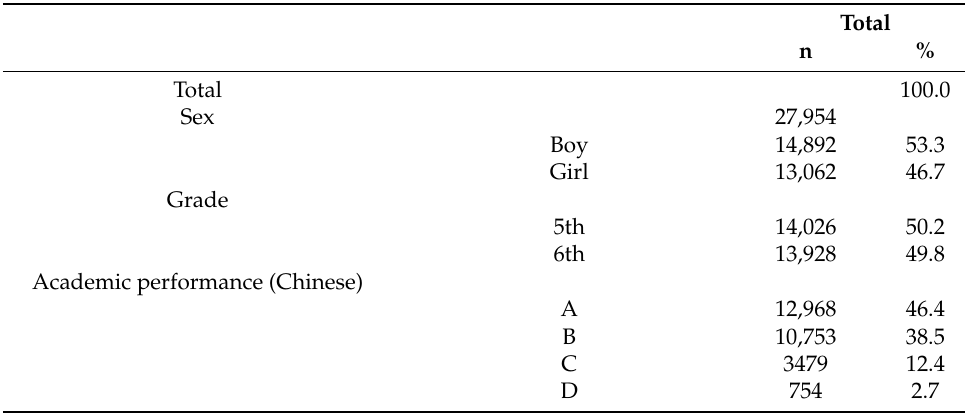
Table 1. Demographic characteristics of study